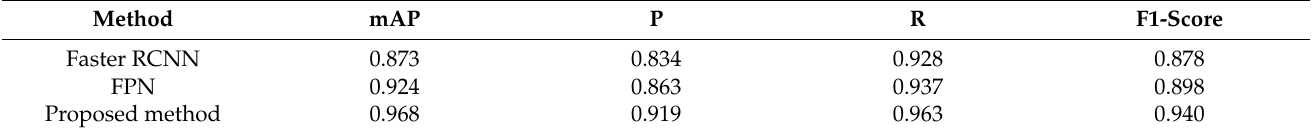
Table 4. Comparison results of the D-MFPN and baseline